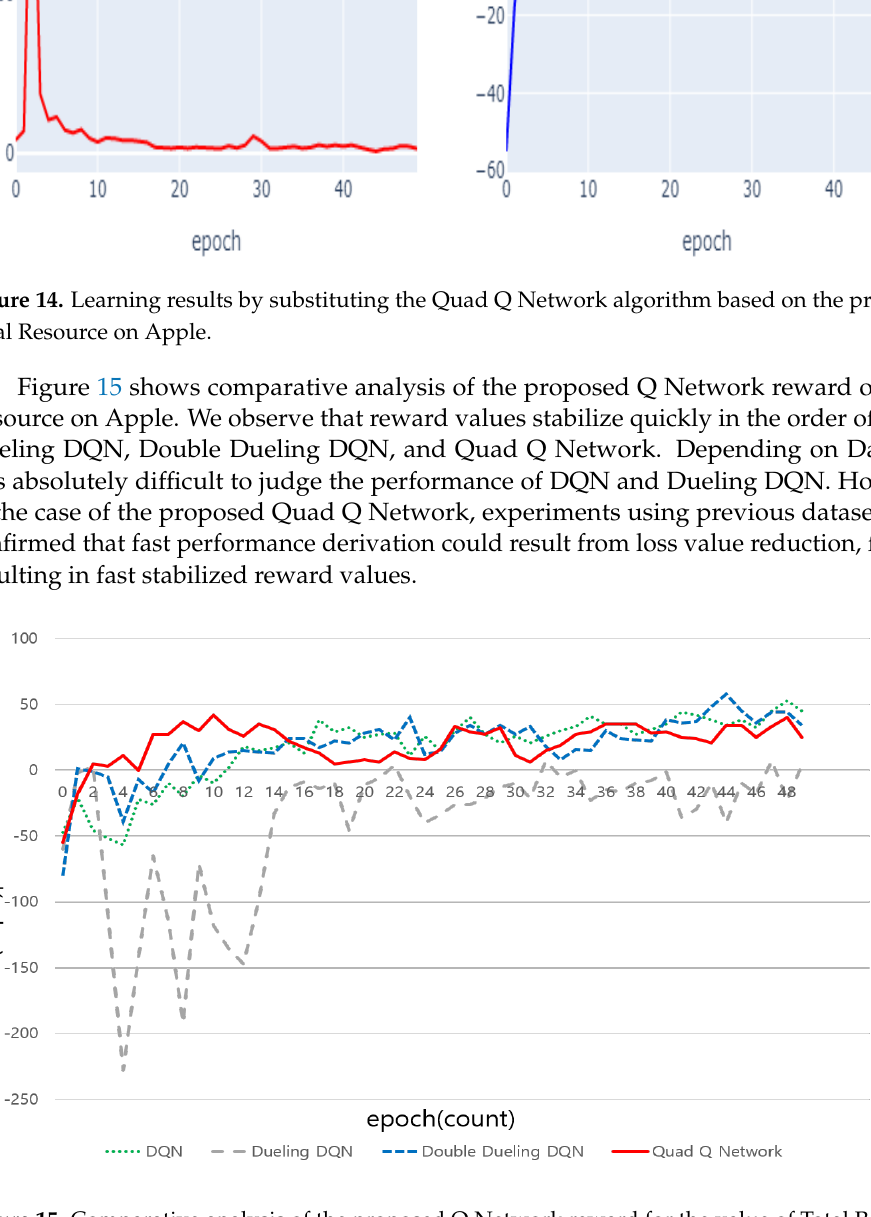
Figure 15. Comparative analysis of the proposed Q Network reward for the value of Total Resource on